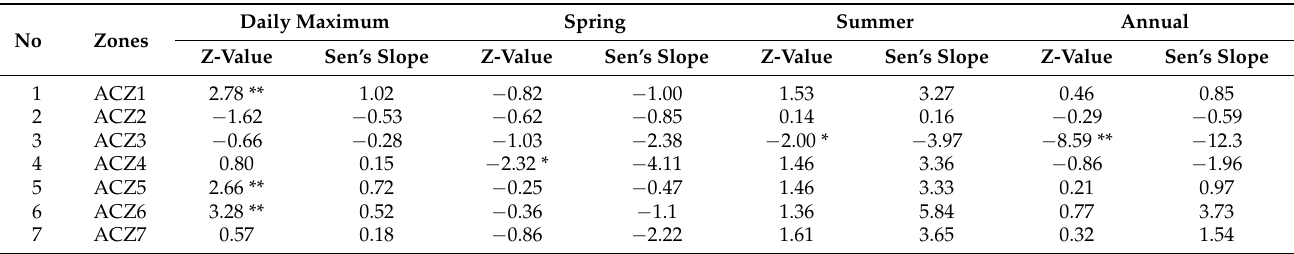
Figure 6. Lag − 1 autocorrelation plot of daily maximum, spring, summer, and annual rainfall. Table 4. Trend analysis results for different time